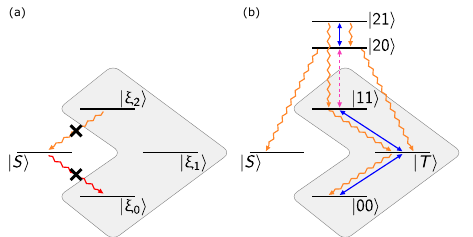
Fig. 2 Minimality of proposed scheme. a Quasi-local dissipation engineered with red- and blue-sideband qubit-oscillator interactions: it is not possible to protect the target Bell state S j i from decay (red arrow) without also suppressing any repumping channel from the orthogonal subspace into the target state (orange arrow). b The effective action of our protocol on the reduced qutrit-qubit subspace. Note how the qutrit levels provide the triplet subspace an indirect path to decay into the singlet subspace (Supplementary Fig.